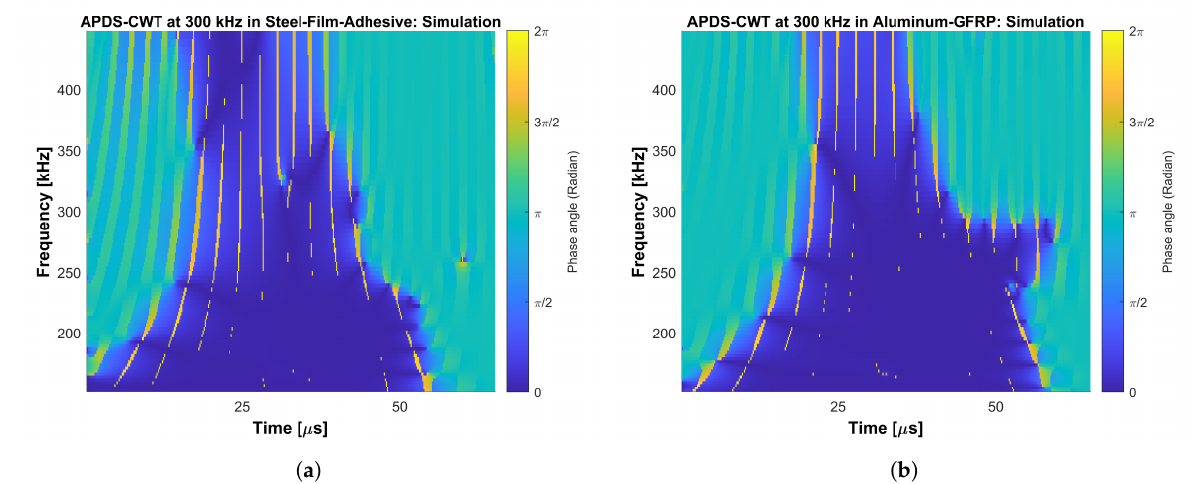
Figure A2. The APDS of the aluminum-GFRP plate and the steel-film adhesive plate: the same characteristics as expected for signal group 1 can be identified. ( a ) APDS-CWT of the steel-film